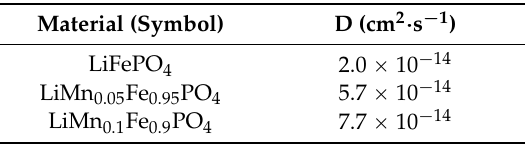
Table 5. Pseudo-diffusion coefficients D (in cm 2 ¨ s ´ 1